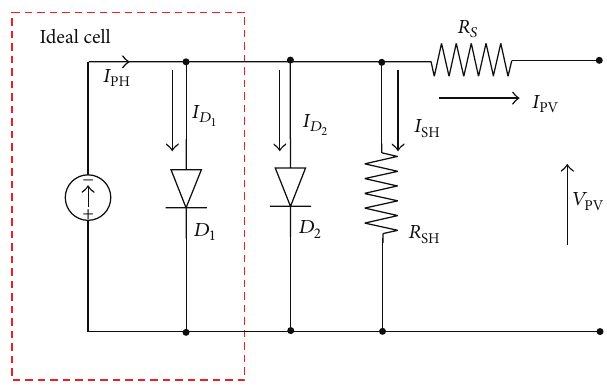
Figure 1: Two-diode model of a photovoltaic